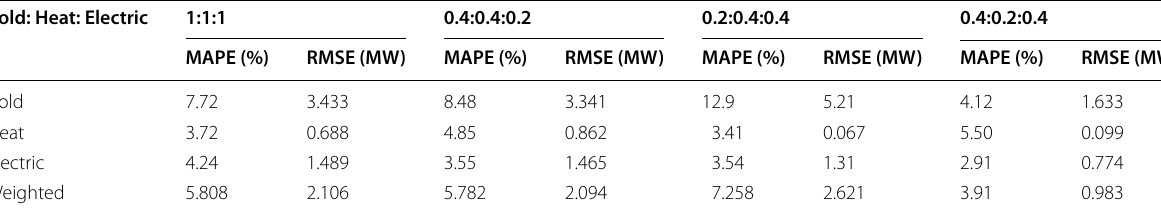
Table 6 The prediction errors by setting different weights Cold: Heat: